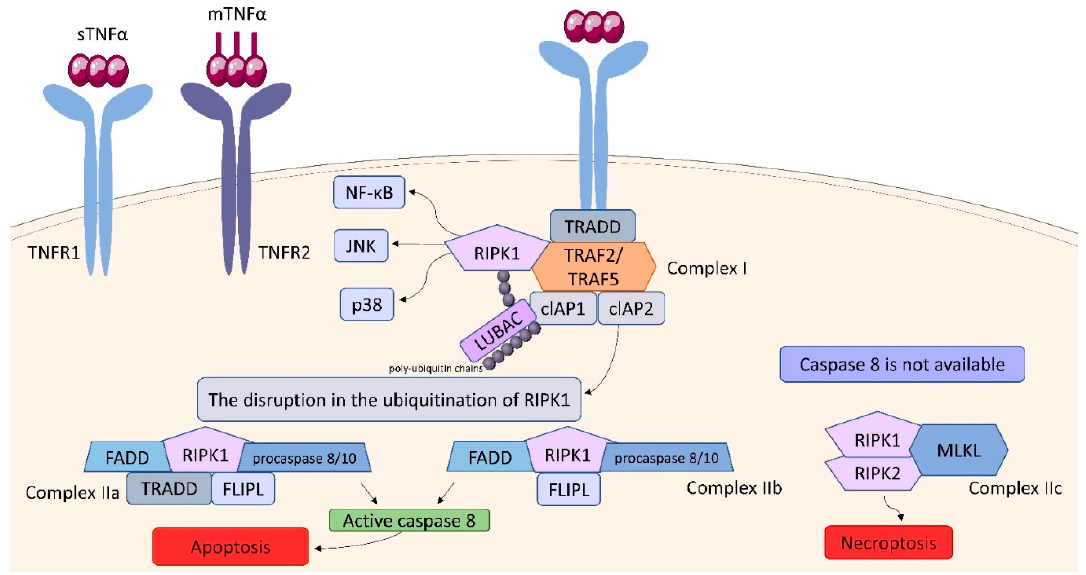
Figure 10. TNFR structure and signaling. Binding of TNF- α to cell surface receptors engages multi- ple signal transduction pathways, including the IKK/NF- κ B, JNK/AP-1 and p38 MAP signaling cas- cades. TNF also can trigger apoptosis via caspase-8 or necroptosis by activating intracellular RIPK